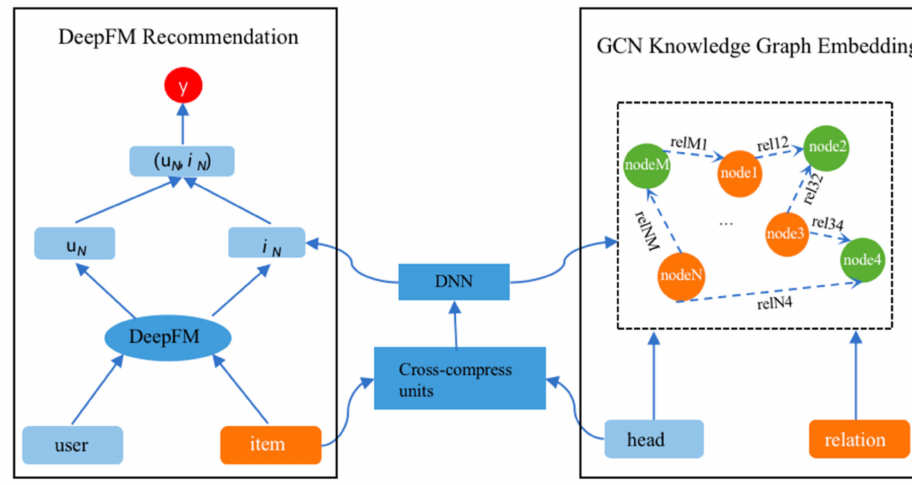
Figure 3. The DFM-GCN network structure model of recommendation